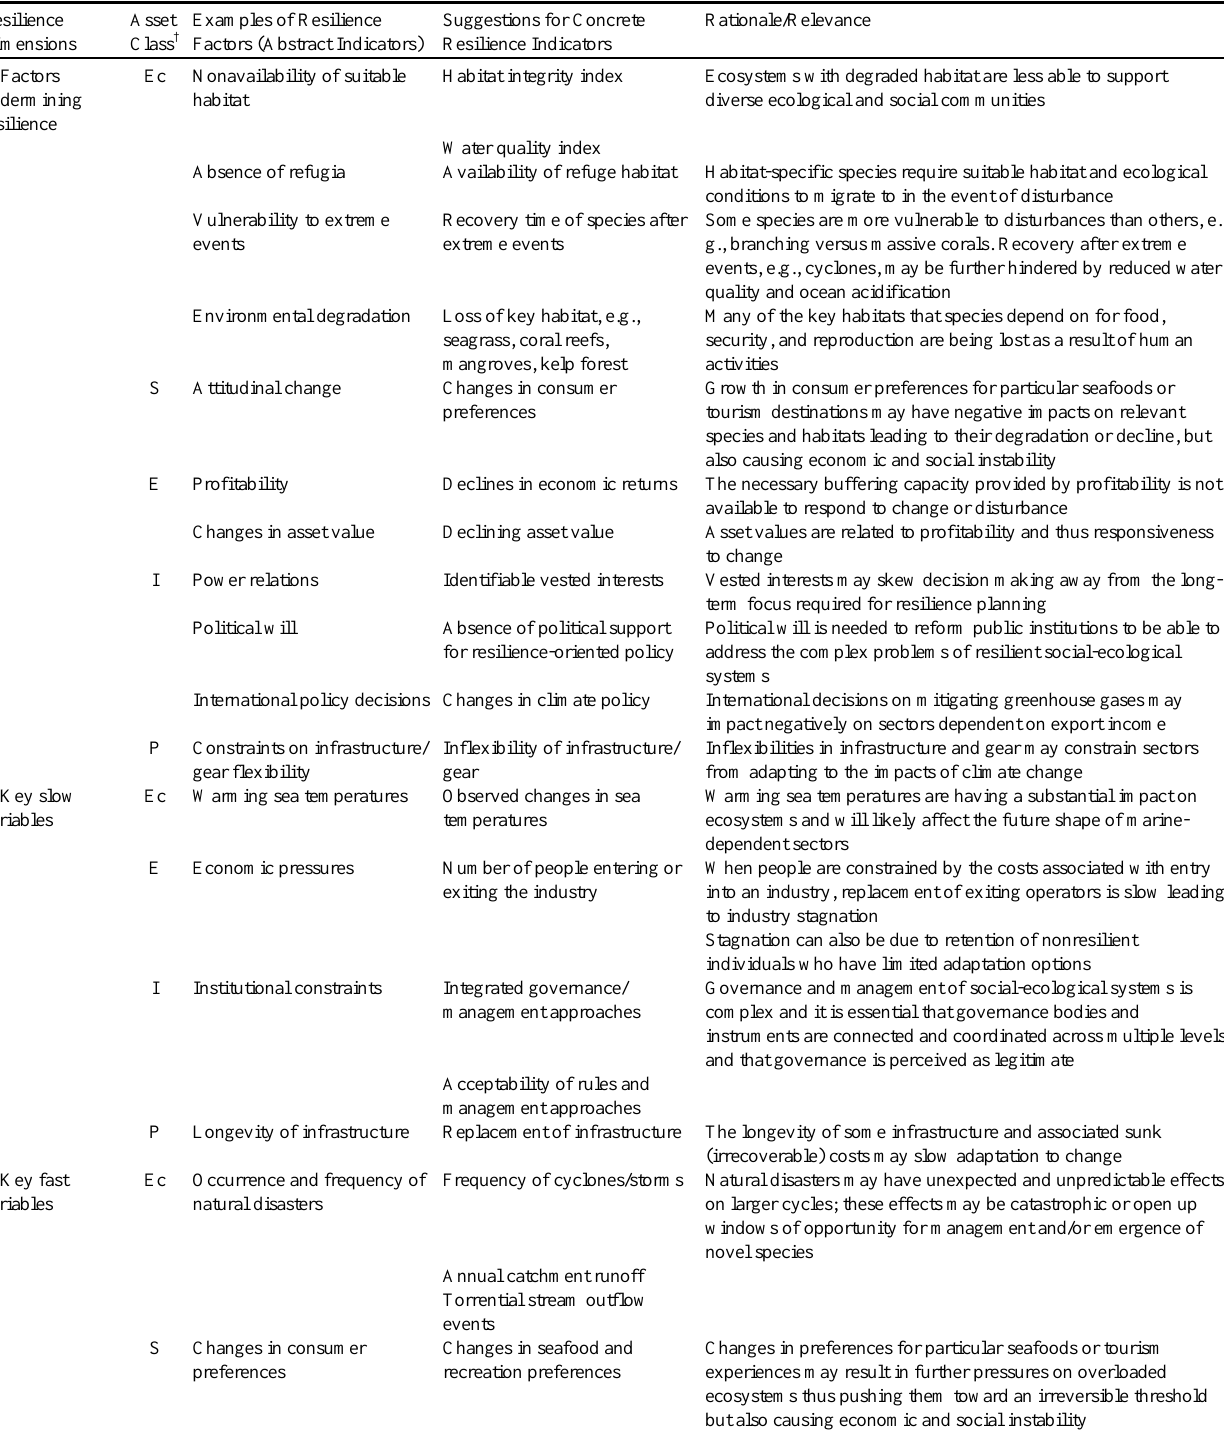
Table 4 . Resilience indicators framework. Resilience